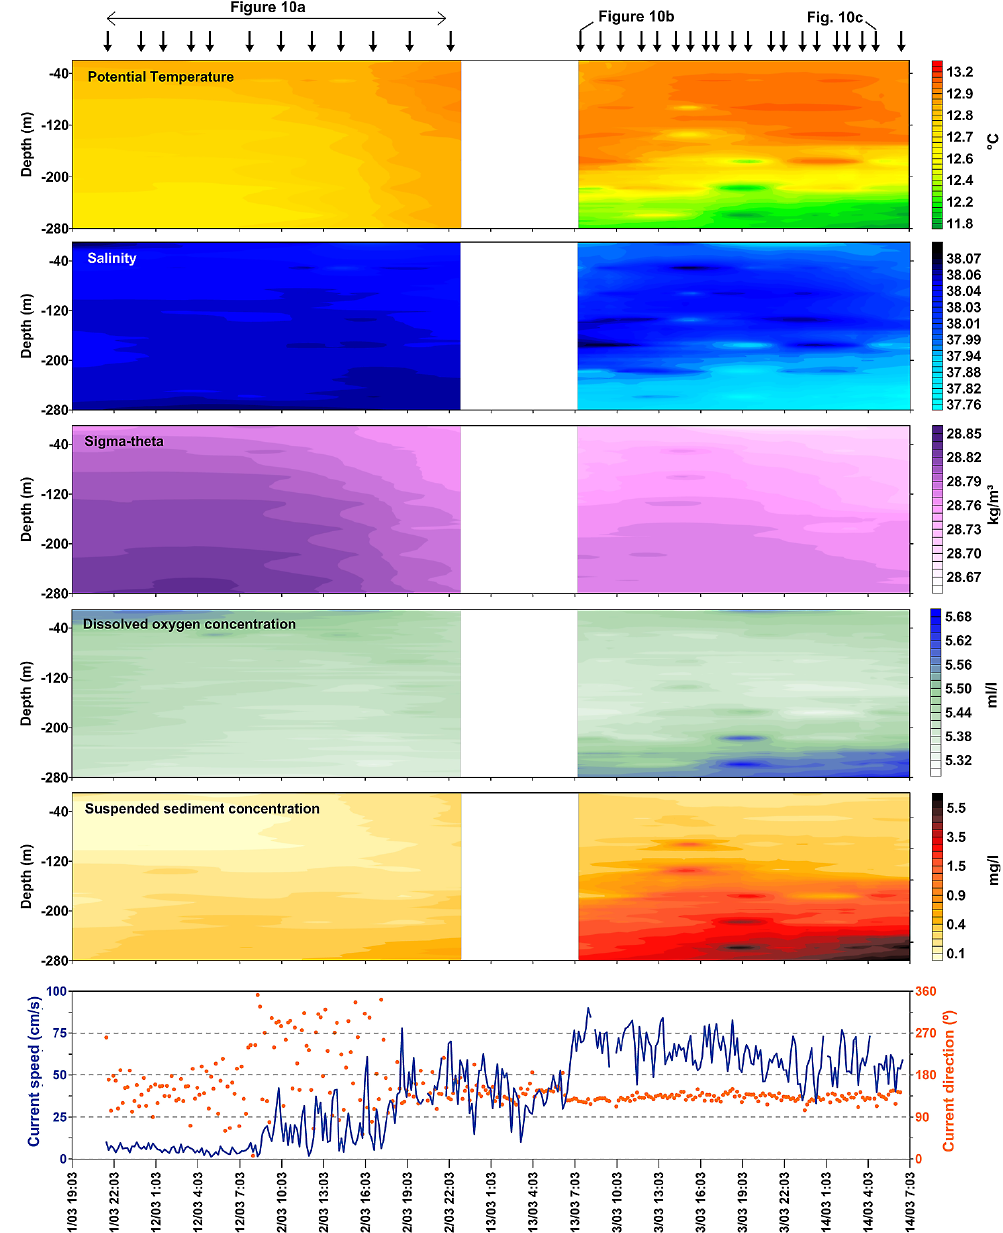
Fig. 5. Distribution of water column properties during the high-resolution temporal sampling at station CX in the Cap de Creus Canyon (see Fig. 1b for location). From top to bottom: potential temperature, salinity, density, dissolved oxygen concentration, and suspended sediment concentration. Arrows indicate the temporal distribution of CTD casts used to create the interpolated contours. Current speed and direction at 210m depth measured by an ADCP installed on the ship hull are also